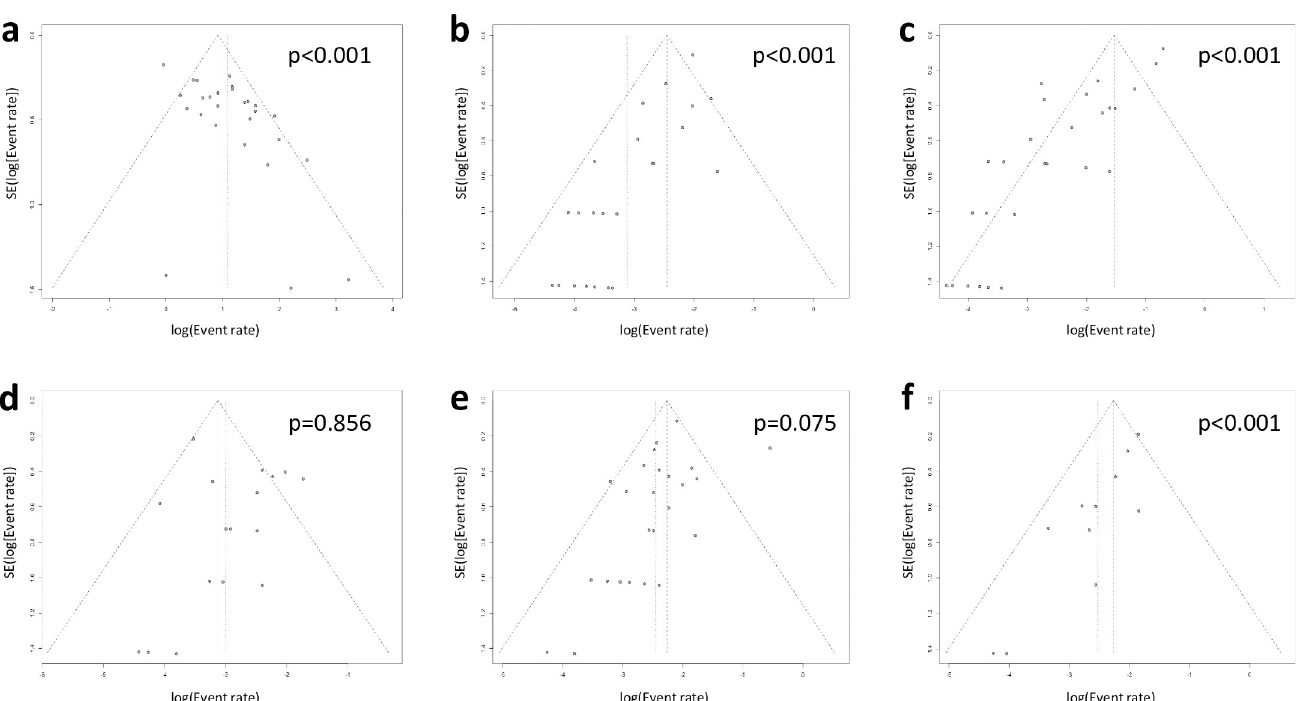
Fig 8. Funnel plots for (a) thrombus resolution, (b) stroke, (c) any thromboembolism, (d) major bleeding, (e) any bleeding, and (f) all-cause death. SE, standard error.